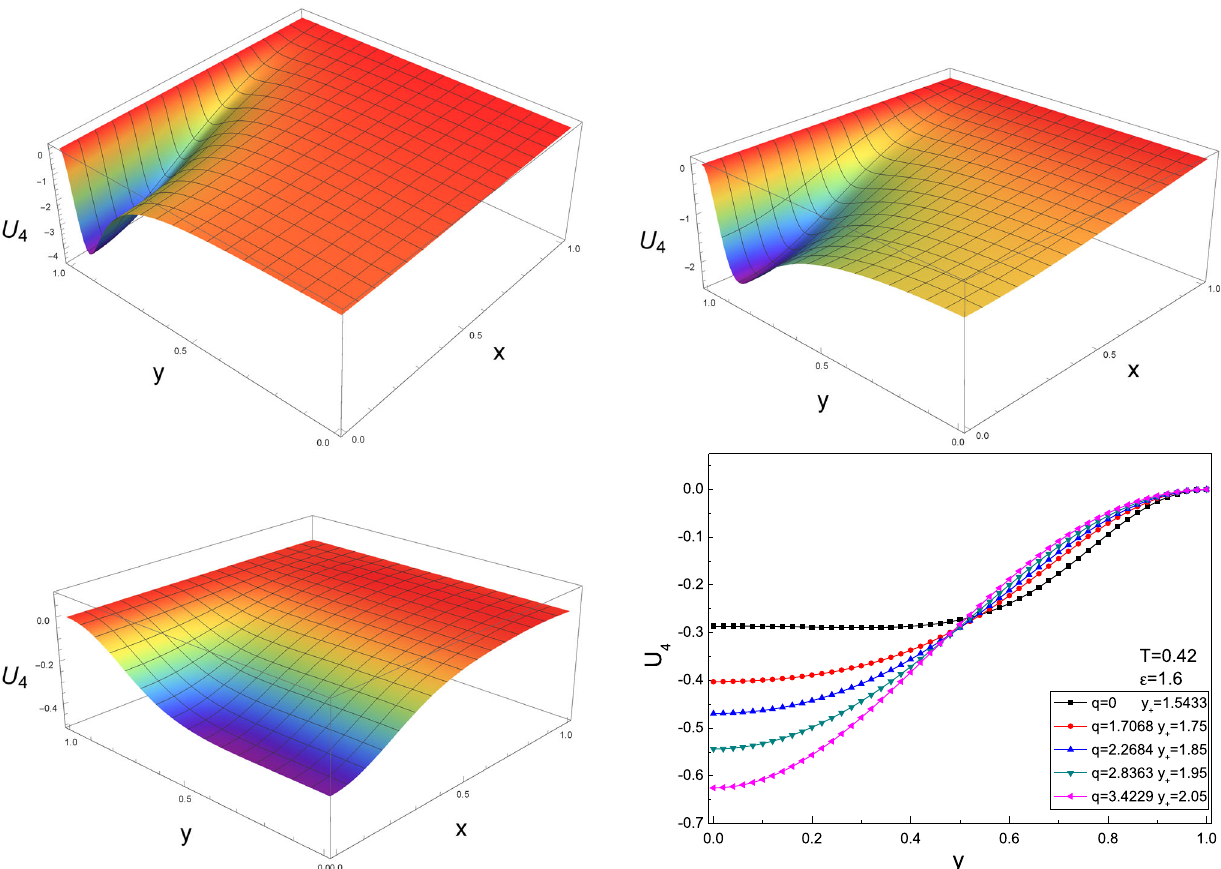
Fig. 2 Top: the plots of U 4 as functions of x and y of two small branches for y + = 0 . 0992 (left) and y + = 0 . 1773 (right). Bottom left: the plots of U 4 as functions of x and y for large branch y + = 1 . 5438. The three solutions of U 4 are given with T = 0 . 42, ε = 1 . 6, δ = 1 and q = 0 . 07057. Bottom right: the plots of U 4 as functions of y at the